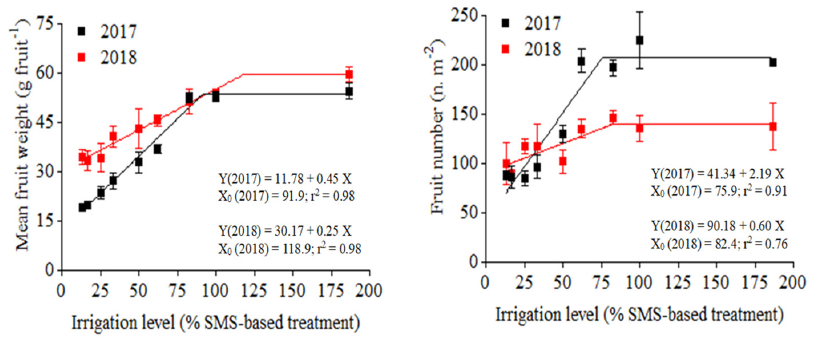
Figure 4. E ff ect of irrigation levels on mean weight and number of marketable tomato fruits in 2017 and 2018. Data are means of three replicates ± standard errors. SMS = soil moisture sensor. Linear- plateau regression models for each year and crop trait are displayed in the fi gure.